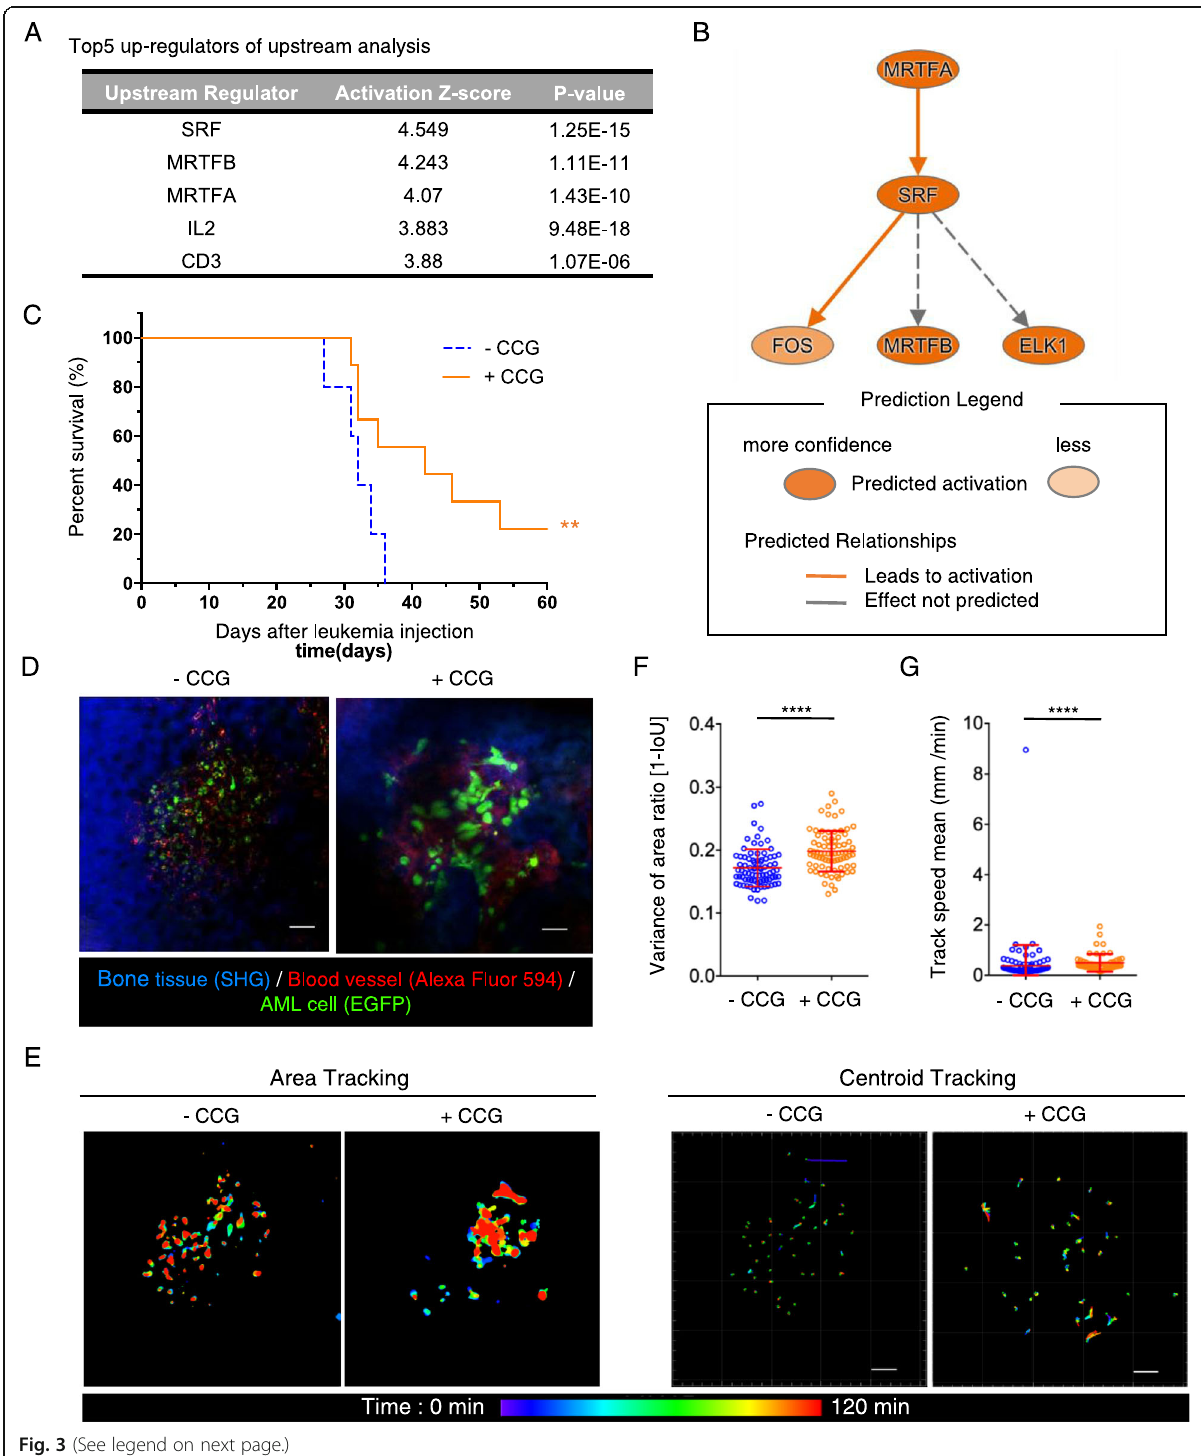
Fig. 3 (See legend on next